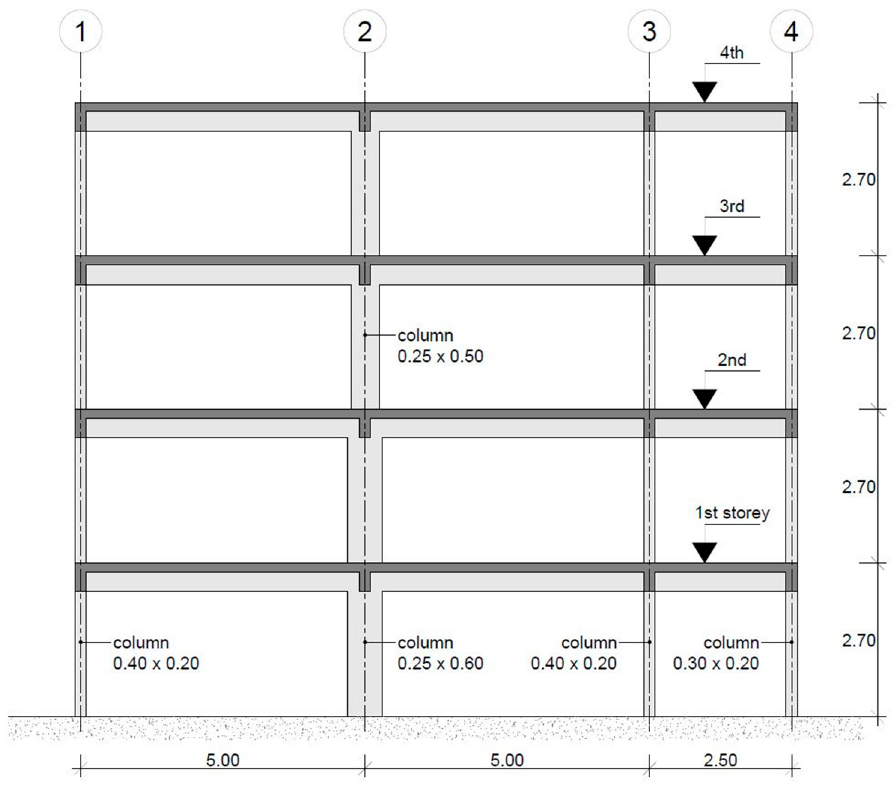
Figure 1. Elevation view of the RC frame (adapted from [8]).